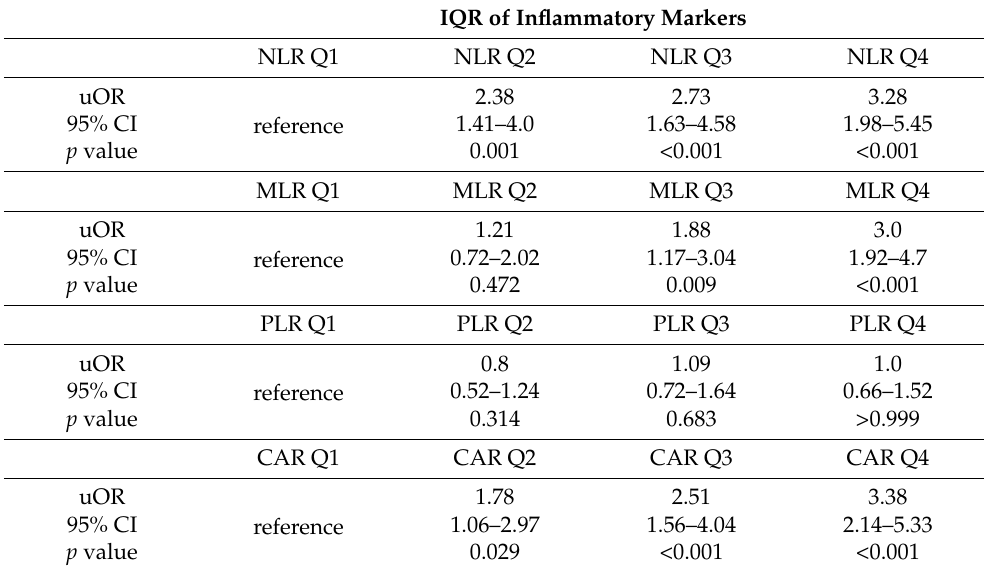
Table 3. Unadjusted odds ratios for the effect of the inflammatory markers on developing POD.